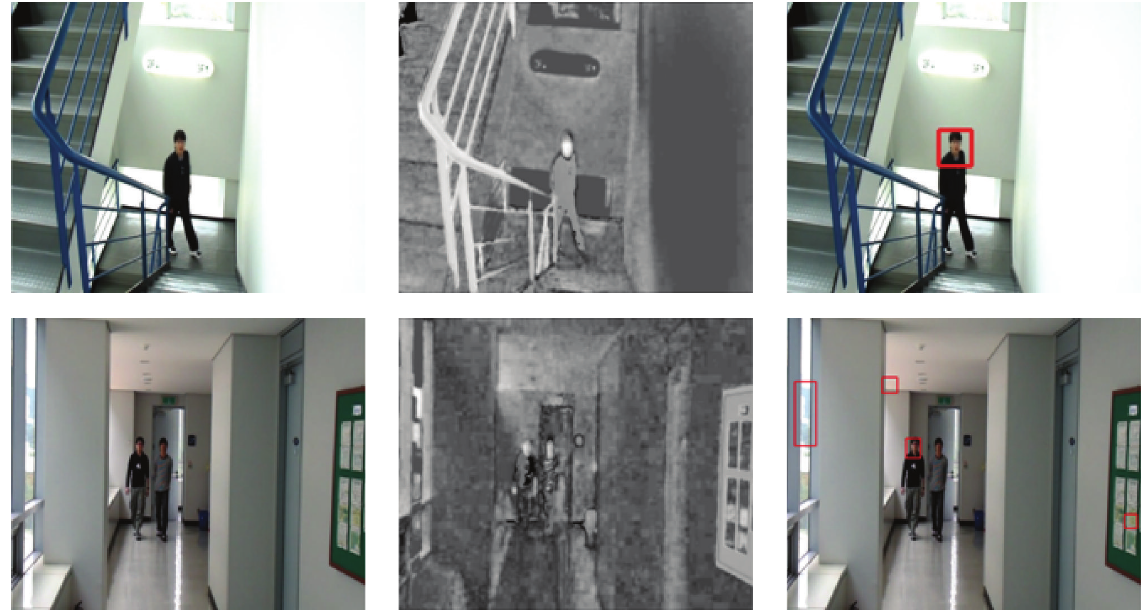
Figure 8: Videos (1) and (2): results using colour saliency [38].